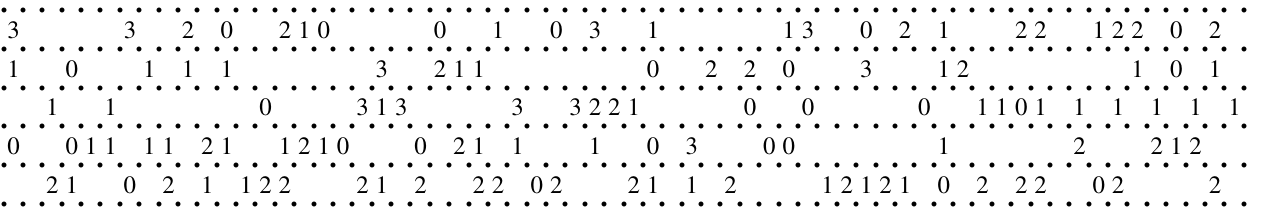
Figure 11. An example of message puzzle